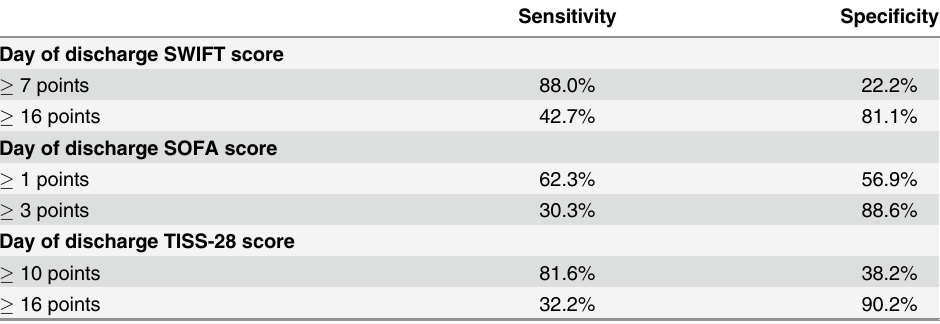
Table 8. Sensitivity and specificity for unplanned intensive care readmission or death according to determined cutoffs for SWIFT, SOFA and TISS-28 scores. Sensitivity Speci fi